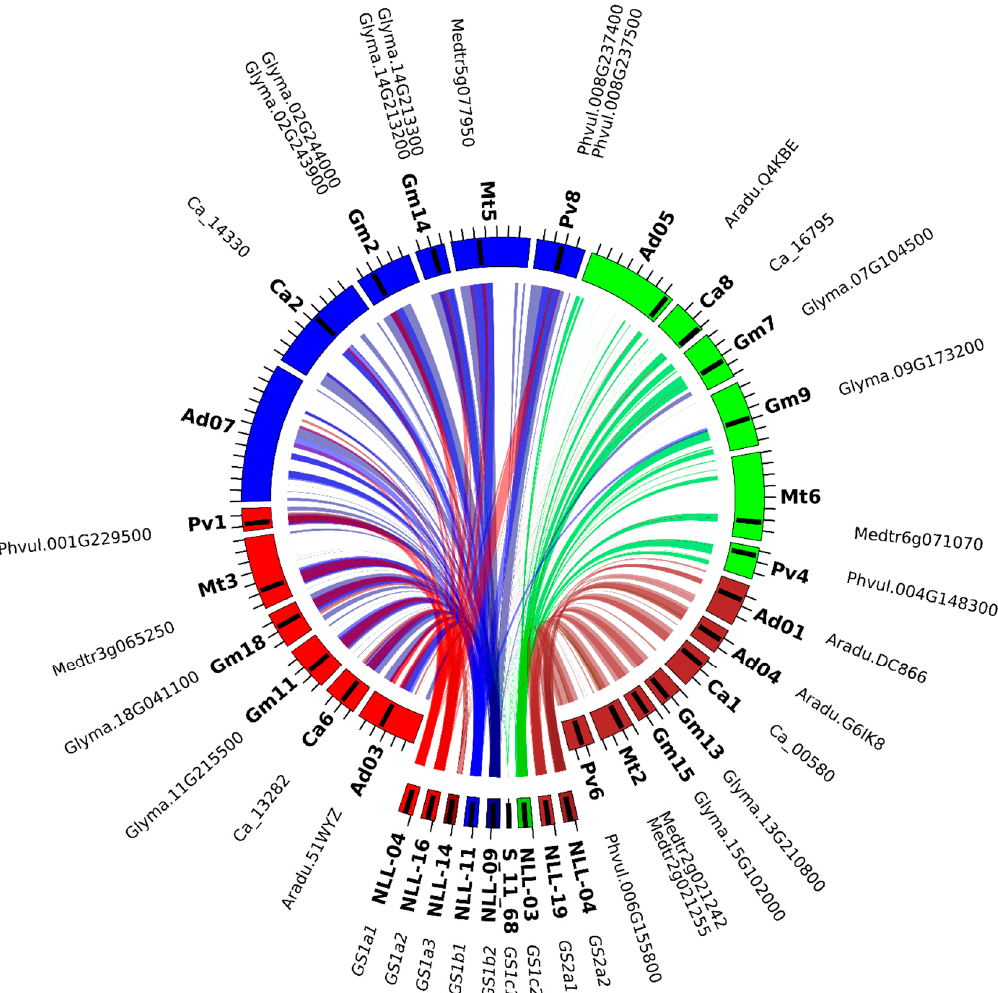
Figure 6. Collinearity links matching narrow-leafed lupin linkage groups and the legume reference genome carrying GS genes. NLL — narrow-leafed lupin linkage group, Pv —P. vulgaris , Mt —M. truncatula , Gm —G. max , Ca —C. arietinum , and Ad —A. duranensis .